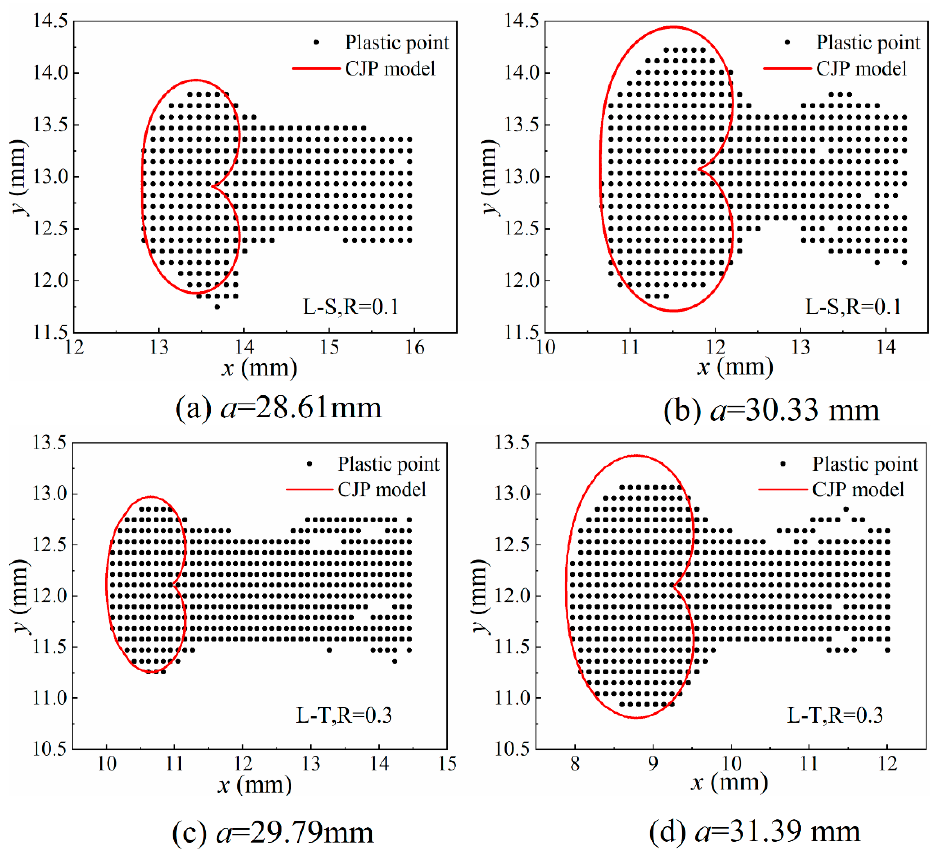
Figure 9. The comparison between the size of the experimental plastic zone and the theoretical plas- tic zone of the CJP model. zone of the CJP